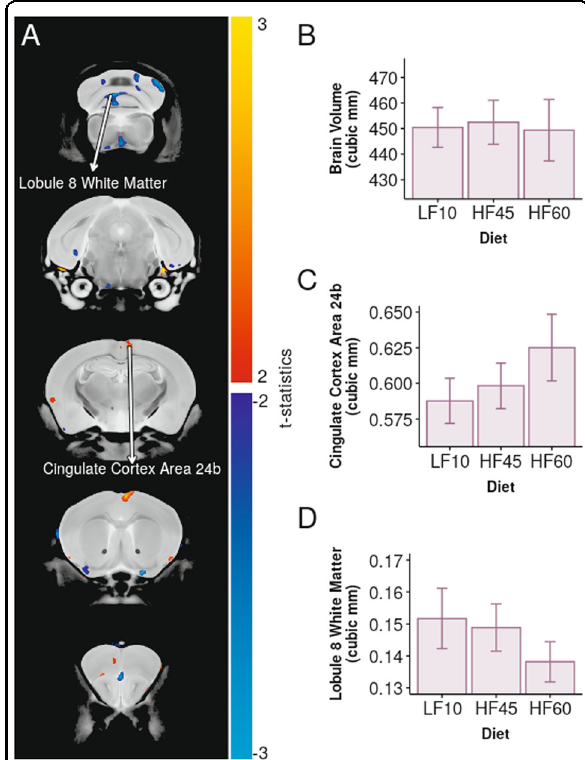
Fig. 2 High-fat diet did not have a signi fi cant effect on the brain structure of dams. A Regional volume did not show signi fi cant negative or positive correlations with dietary fat-percentage (blue/ turquoise and red/yellow colour scale, respectively). B Total brain volume was not signi fi cantly affected by diet ( F 1,22 = 0.003, p = 0.96). Cingulate cortex area 24b and White matter of cerebellar lobule 8 had the largest effects, but were not signi fi cant (ns). C Cingulate cortex area 24b showed increased volume with increased fat-percentage ( t 22 = 2.5, p = 0.02,FDR = 0.92, ns). D White matter of cerebellar lobule 8 showed decreased volume with increased fat-percentage ( t 22 = − 2.13, p = 0.045,FDR = 0.98,